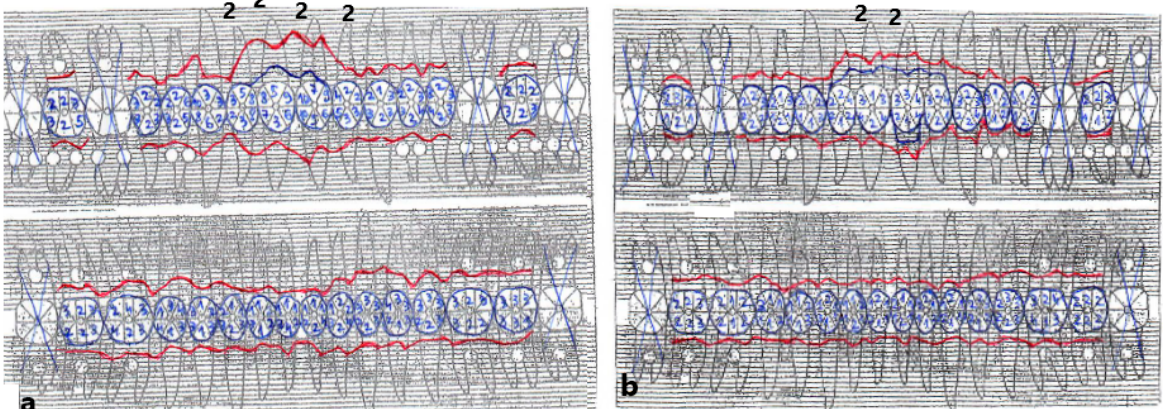
Figure 2. Periodontal chart before treatment ( a ) and after treatment ( b ) (Department of Periodon- tology, Carol Davila University of Medicine and Pharmacy). Red line—probing depth (PD), blue line—gingival margin, crossed tooth—excluded tooth, class 2—tooth mobility (Miller Classification).